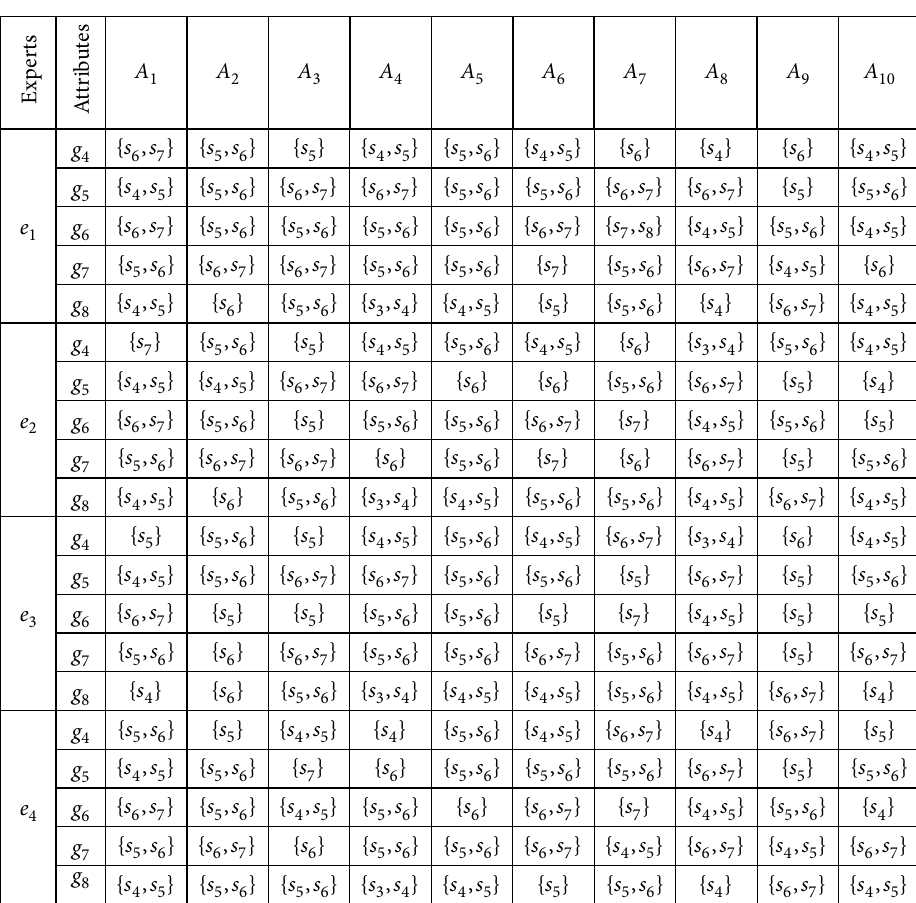
Table 4. Performance of projects on qualitative attributes (source: created by the